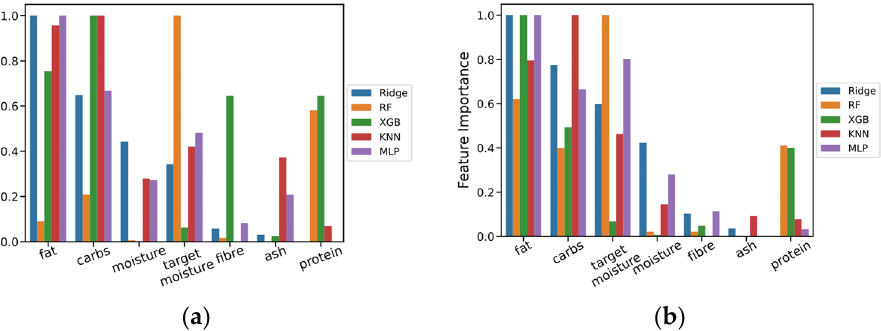
Figure 5. Feature importance scores across models: Ridge, RF, XGBoost, KNN, and MLP. ( a ) Feature importance scores for Hardness; ( b ) Feature importance scores for Chewiness.